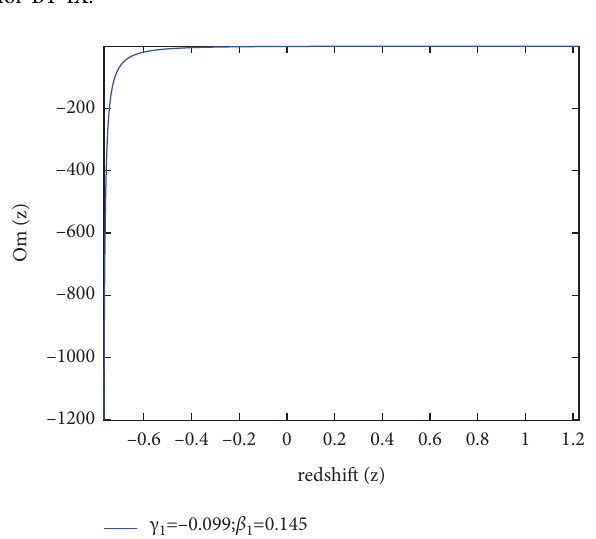
Figure 27: Density parameter of VHDE ( Ω for BT-IX.